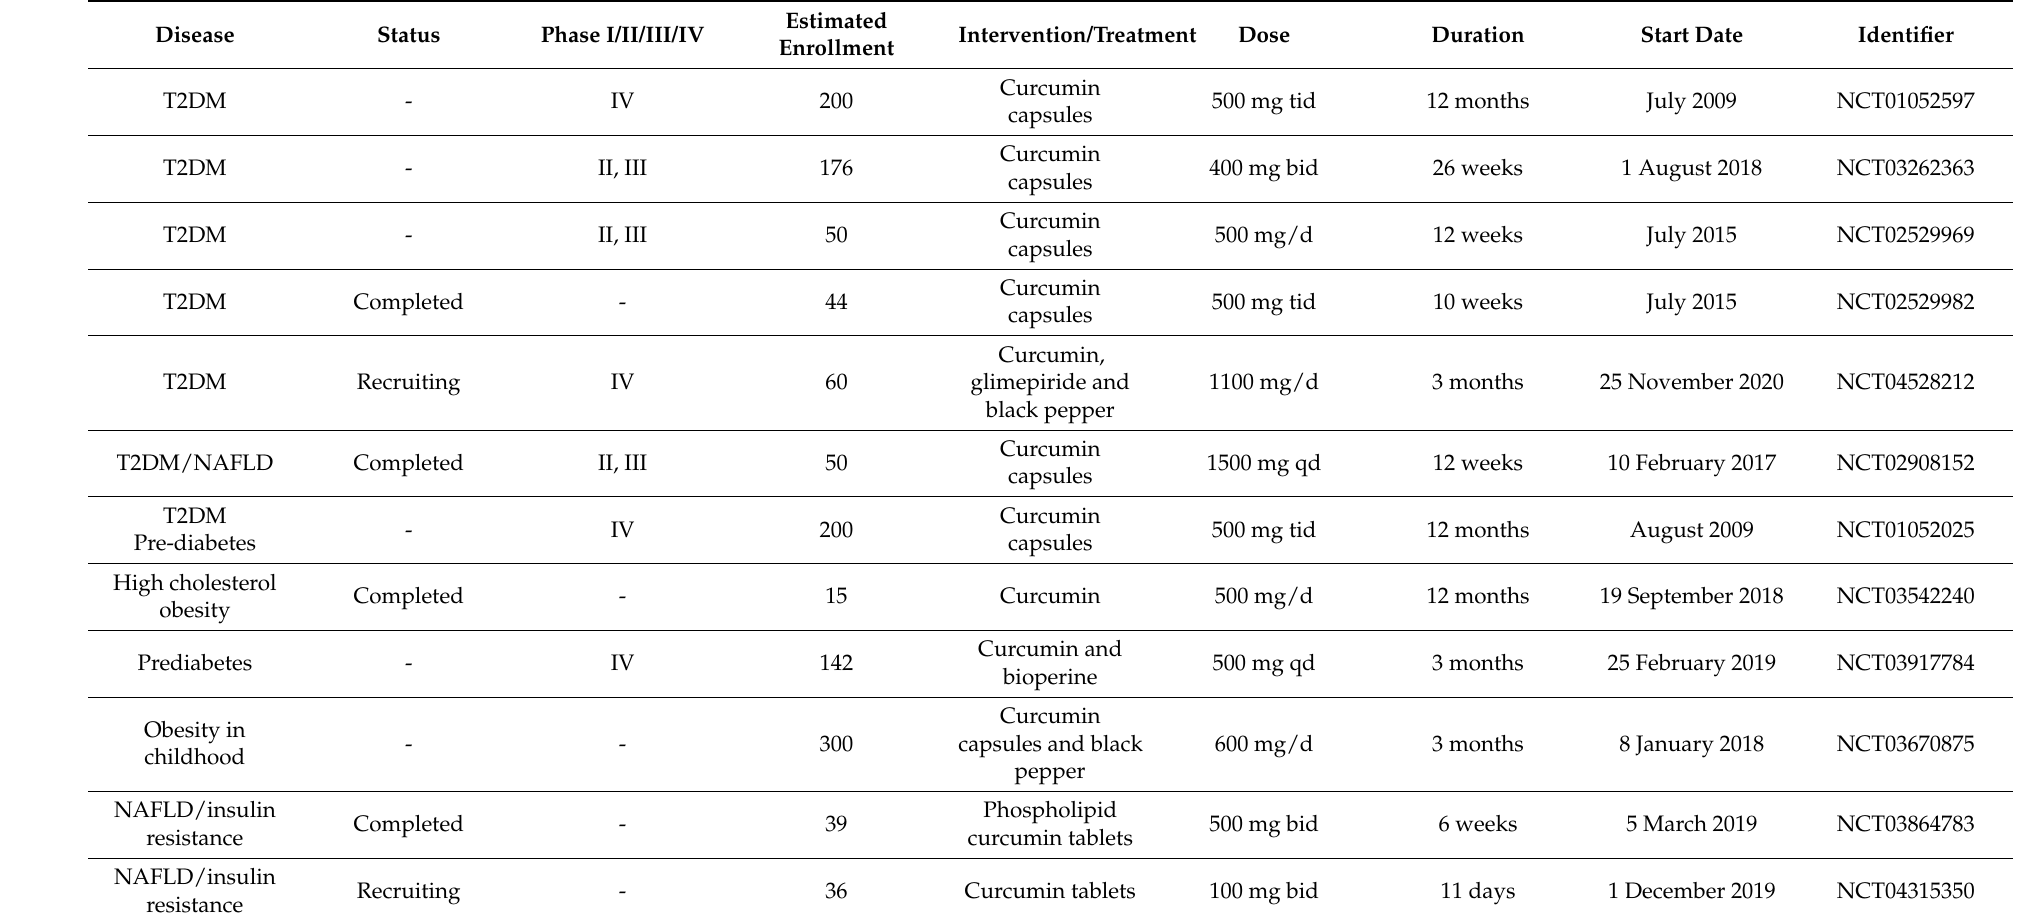
Table 1. Clinical trials of curcumin in treating metabolic diseases registered at